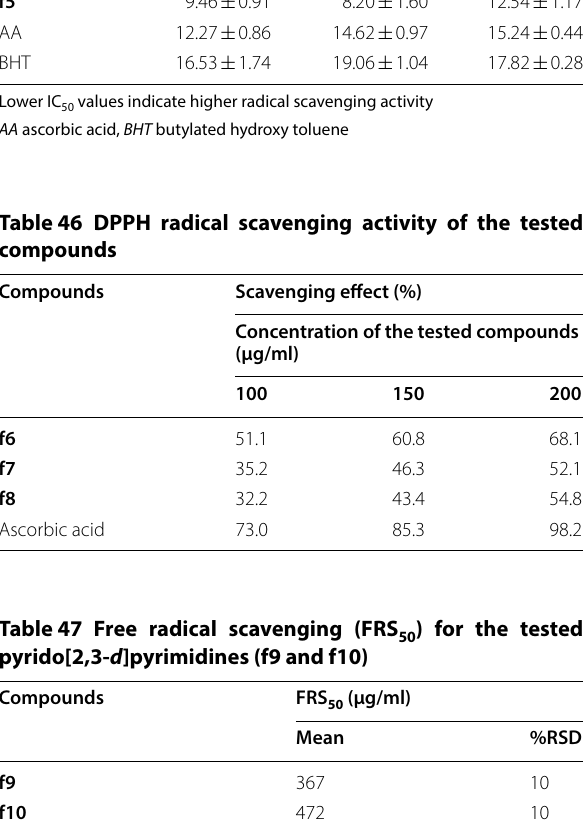
Table 45 Antioxidant activity of most compounds Compounds